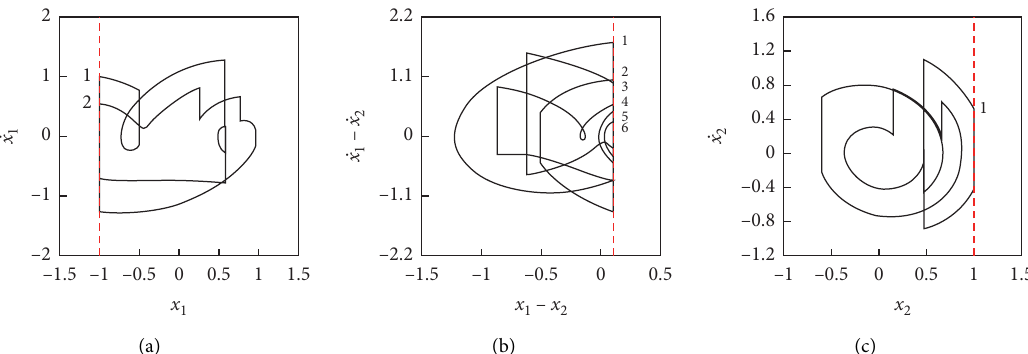
Figure 6: Phase plane portraits of periodic motion when δ � 0 . 1 and ω � 0 . 85. (a) Phase plane portraits of M portraits of relative displacement and relative velocity of M